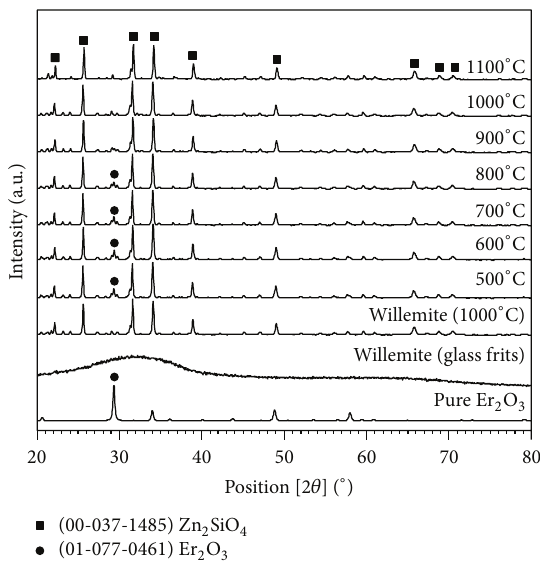
Figure 1: The XRD patterns of the willemite-based glass-ceramic (Zn 2 SiO 4 ) sample doped with 3 wt% Er 2 O 3 sintered at the tempera- ture of 500–1100 ∘ C for